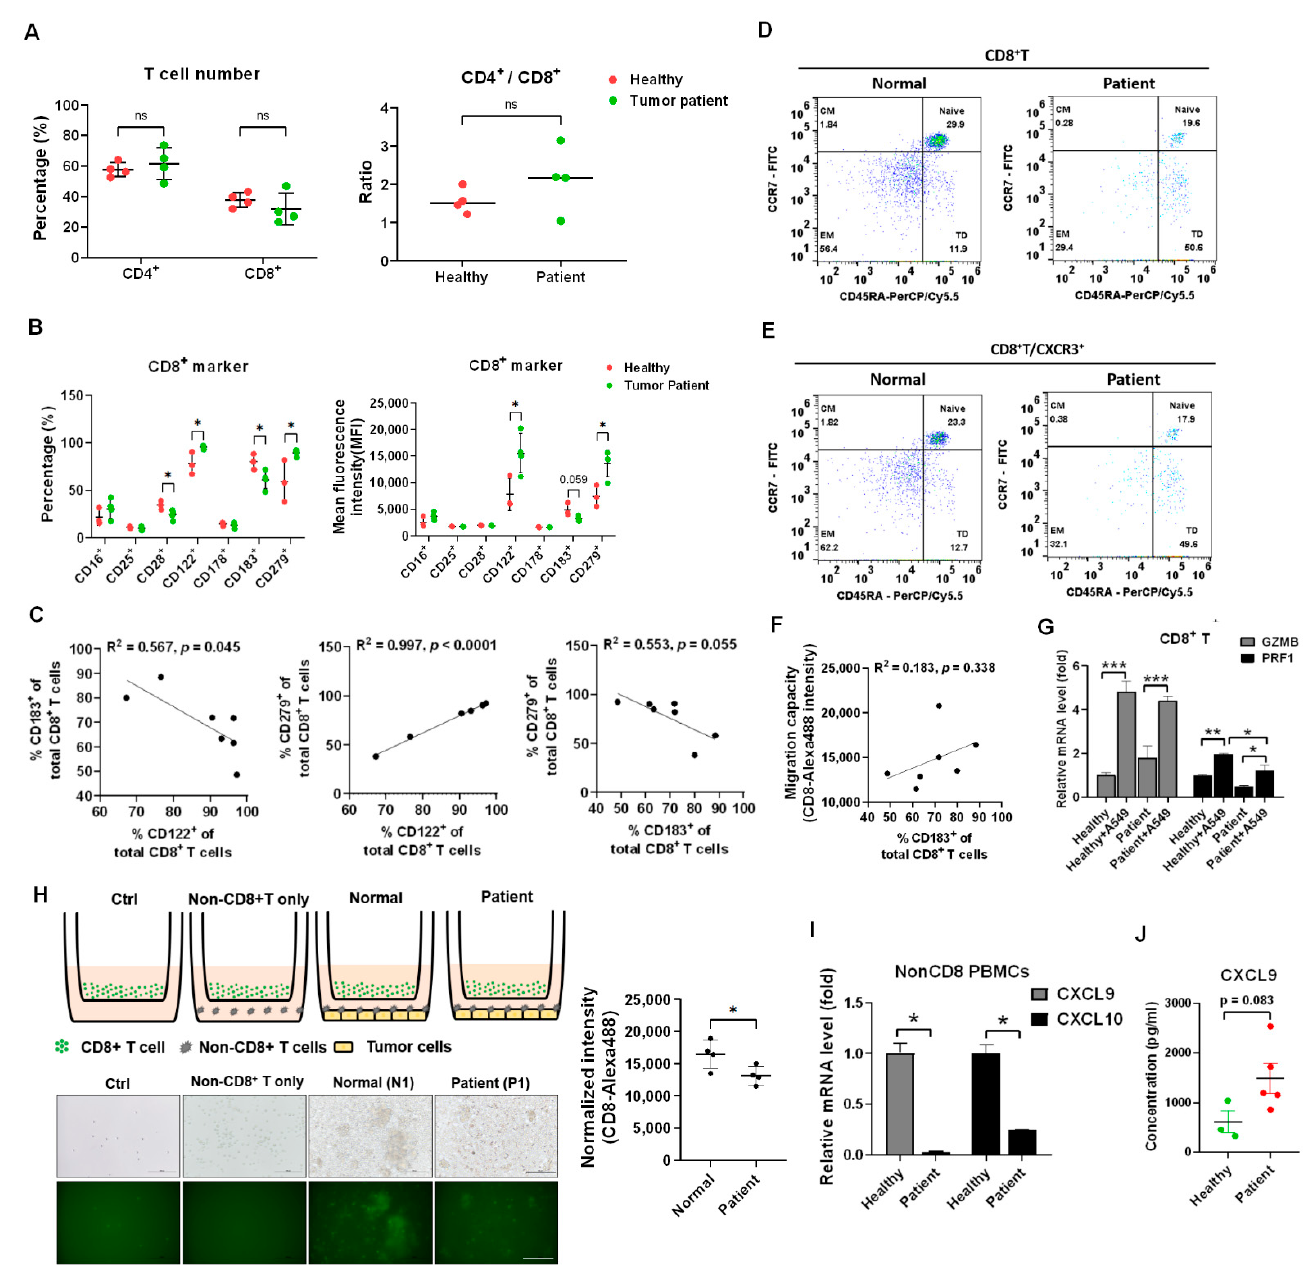
Figure 4. Reduction of CD8 + T cells migration in vitro in the patients with lung cancer. ( A ) The cell percentage of CD4 + T and CD8 + T cells was measured between the healthy volunteers and the patients with lung cancer. The CD4 + /CD8 + ratio was also compared. ns: non-significance. ( B ) Th CD8 + T cell markers were detected and compared between the healthy volunteers and the patient with lung cancer, including activation markers: CD16, CD25, CD28, CD122, CD178, migratory marker: CD183 (CXCR3), and inhibitory marker: CD279 (PD-1). ( C ) The correlation among CD122, CD183, and CD279 was analyzed. ( D ) CD8 + T cells between the healthy volunteers and the patients with lung cancer were classified into four subsets based on the expression of CD45RA and CCR7 by flow cytometry (Naïve: CD45RA + CCR7 + ; Central-memory (CM): CD45RA − CCR7 + ; Effector-memory (EM): CD45RA − CCR7 − ; and Terminally differentiated (TD): CD45RA + CCR7 − ). ( E ) The CD183 (CXCR3) expression was detected in the four subsets of CD8 + T cells. ( F ) The correlation between CD183 (CXCR3) expression and the CD8 + T cell migration ability was analyzed in the healthy volunteers and the patients with lung cancer. ( G ) The A549 cells with incubated with PBMCs from a healthy volunteer and a patient with lung cancer for 24 h, and CD8 + T cells were isolated and analyzed for GZMB and PRF1 expression by qPCR. ( H ) The CD8 + T cells migration was compared between the healthy volunteers (n = 4) and the patients with lung cancer (n = 4). Scale bar, 100 μ m. ( I ) The non-CD8 + PBMCs between a healthy volunteer and a patient with lung cancer were analyzed for CXCL9 and CXCL10 expression. ( J ) The CXCL9 concentration was measured using an ELISA technique between the healthy volunteers (n = 3) and the patients